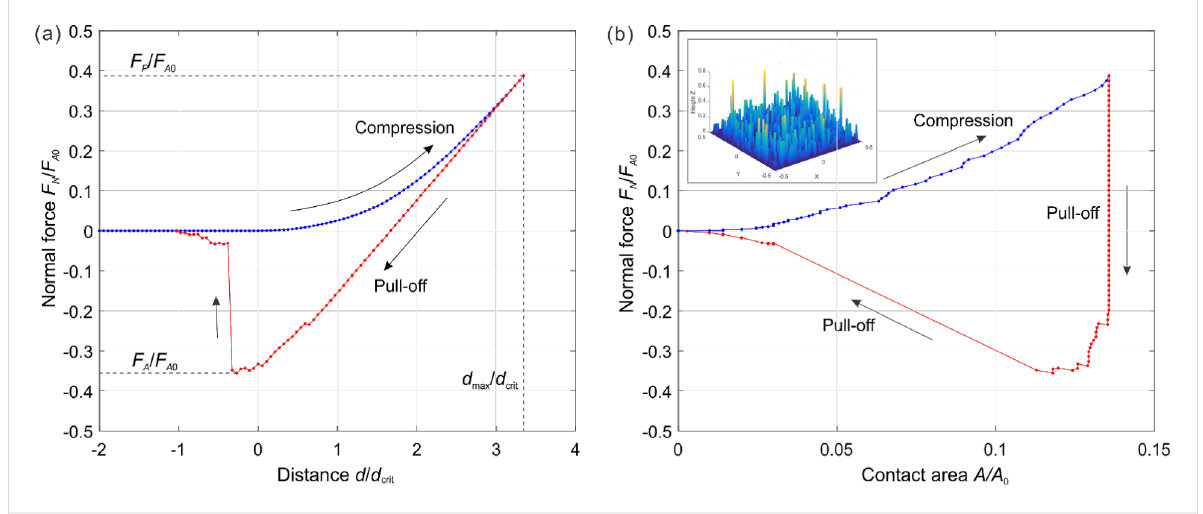
Figure 3: An example of a pillar structure in compression and pull-off contact: (a) load–distance relation; (b) load–contact area relation. Parameters used in this simulation were: Number of pillars: 1000, filling factor: ρ = 0.3, normalized roughness: l / d crit = 0.42. (a) also provides the exact definition of the preliminary compression force, F p , and the force of adhesion, F A .